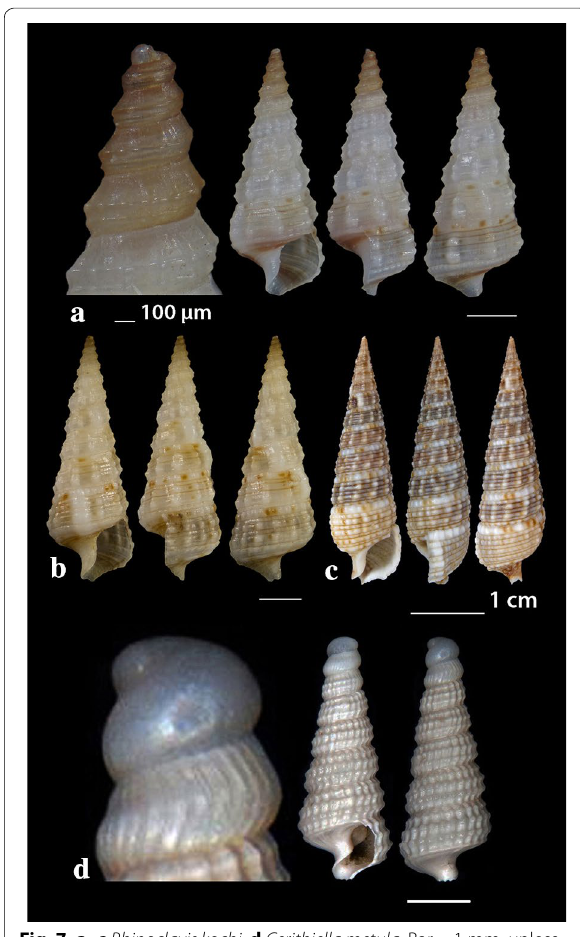
Fig. 7 a – c Rhinoclavis kochi , d Cerithiella metula. Bar otherwise